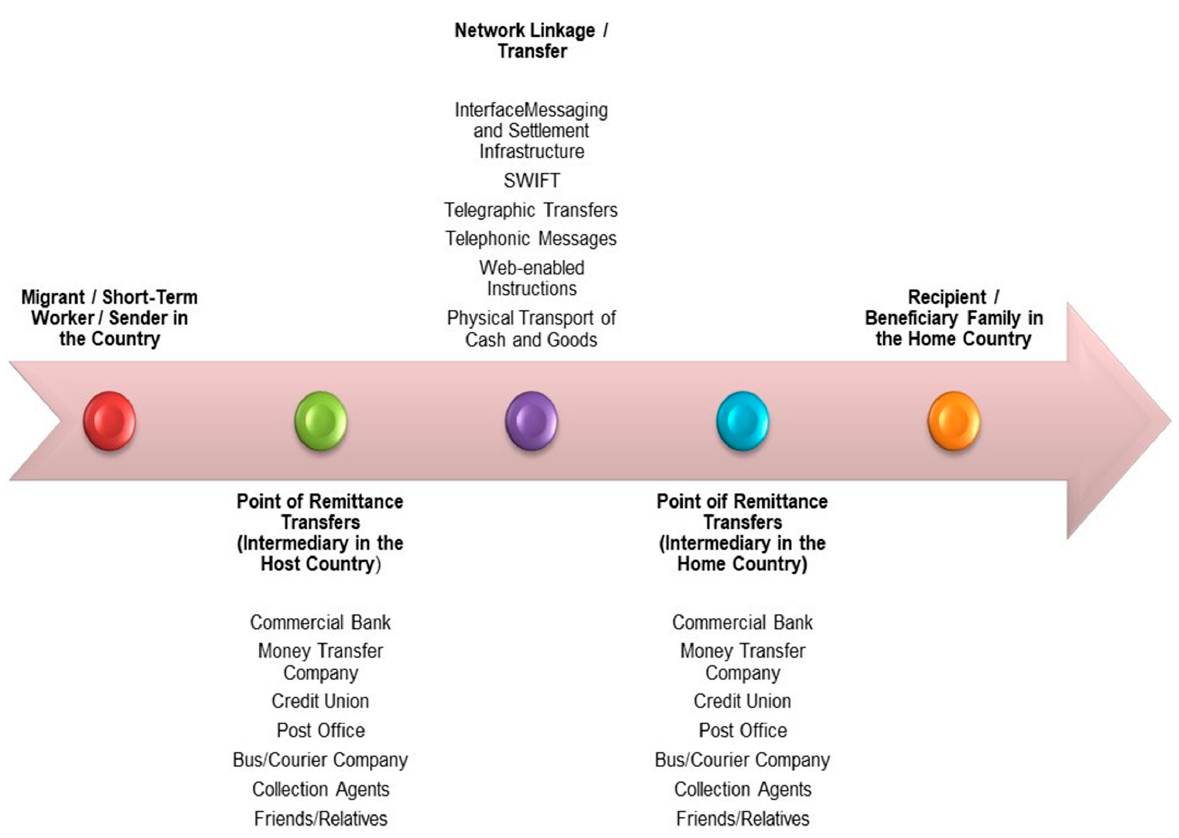
Figure 4. Remittance channels.